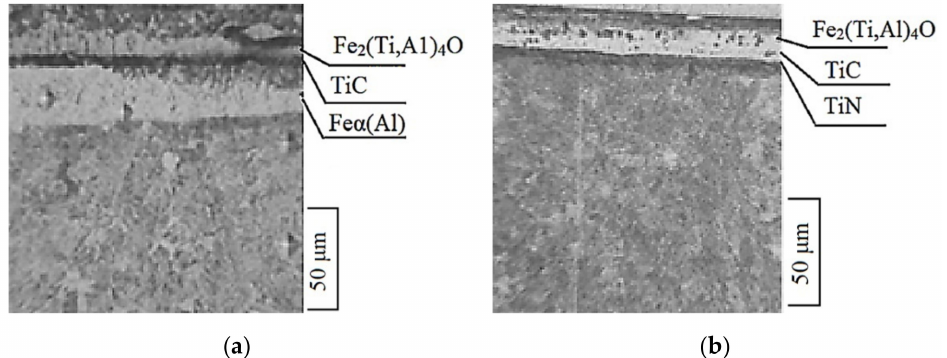
Figure 3. Microstructures of titanium aluminized coatings on AISI W1-7 steel; ( a , b ) light microscope; × 300; ( b ) a layer of TiN applied to AISI W1-7 steel before the titanium aluminizing; titanium aluminizing (1050 ◦ C, 4